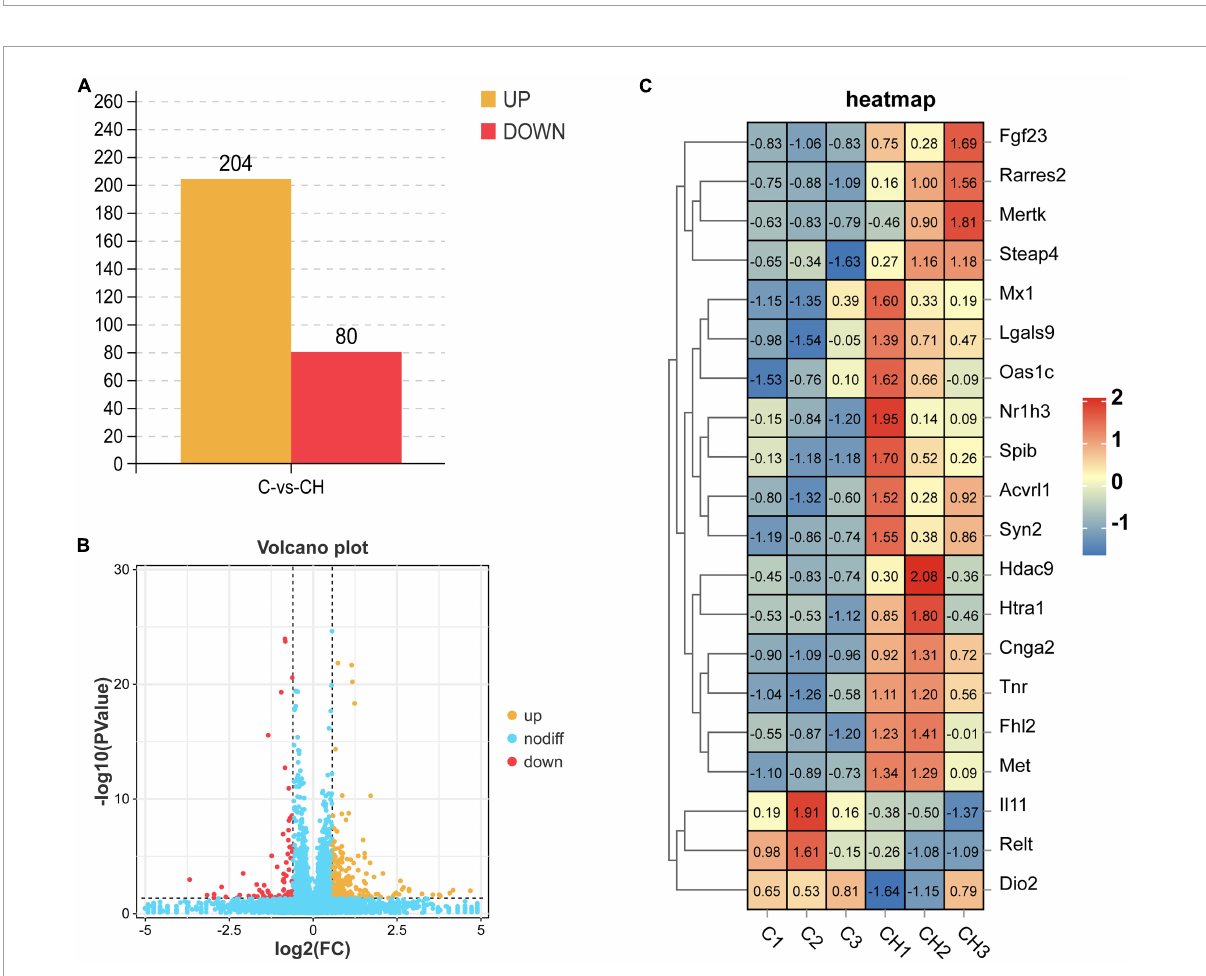
FIGURE4 Holistic statistics (A) , volcano plot analysis (B) , and correlation heatmap (C) of DEGs in C-vs.-CH. C represents three untreated control samples; CH represents three chlorantraniliprole-treated treatment group